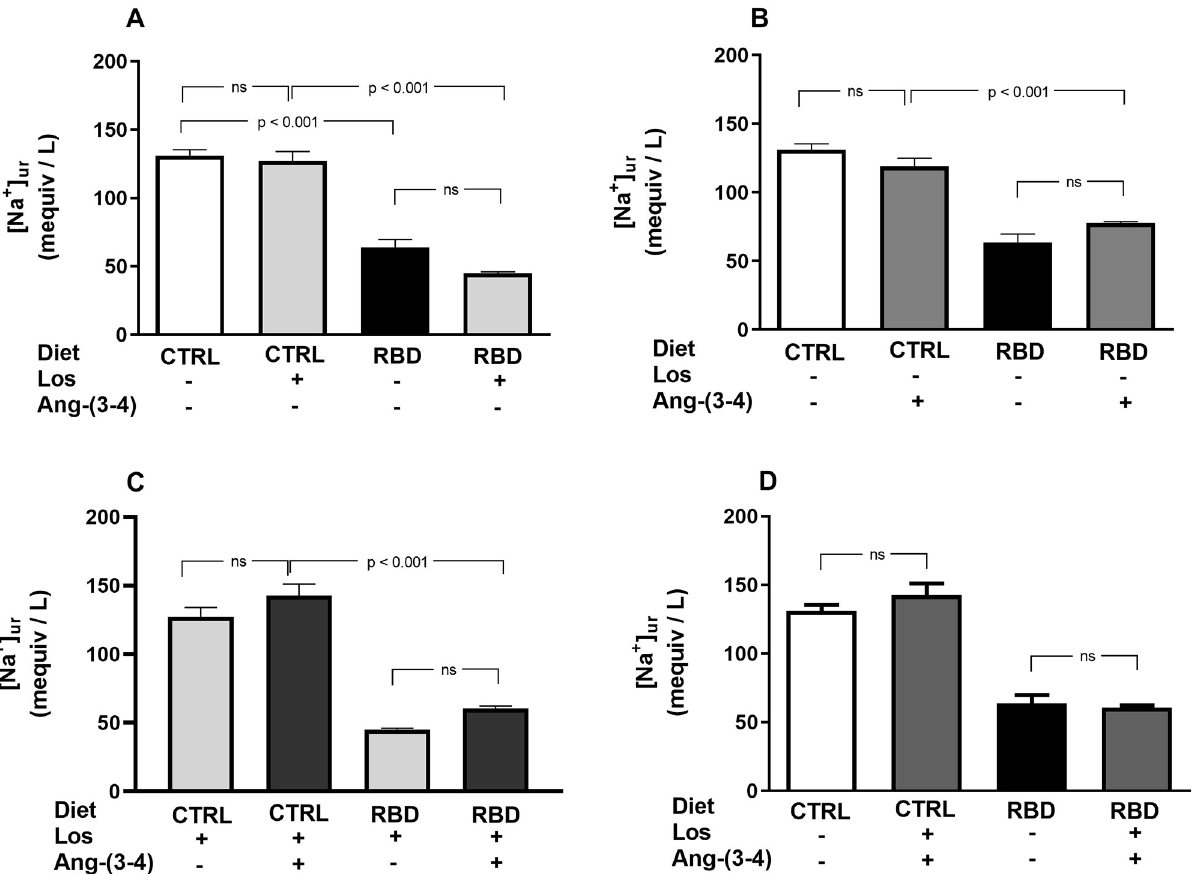
Fig 9. Urinary Na + concentration ([Na + ] ur ). Urine samples were collected between 90 and 91 days, except for Ang-(3–4)-treated rats, which were collected between 91 and 92 days. (A) Responses to Losartan. Comparison of [Na + ] ur in CTRL and RBD rats without chronic administration of Losartan, and effects of Losartan administration, as indicated on the abscissa . (B) Responses to Ang-(3–4). Effects of oral administration of a single dose of Ang-(3–4) on the [Na + ] ur of CTRL and RBD rats, as indicated on the abscissa . (C) Responses to Ang-(3–4) in rats previously treated with Losartan. Effects of oral administration of a single dose of Ang-(3–4) on the [Na + ] ur of CTRL and RBD rats previously treated with Losartan, as indicated on the abscissa . (D) Effects of combined Losartan+Ang-(3–4) administration. Comparison of [Na + ] ur between untreated CTRL and RBD rats vs . CTRL and RBD rats that were chronically given Losartan and a single dose of Ang-(3–4), as indicated on the abscissa . Bars are mean ± SEM; n = 5 (CTRL), n = 7 (RBD), n = 5 (CTRL+Los), n = 6 (RBD+Los), n = 5 (CTRL+Ang-(3–4)), n = 8 (RBD+Ang-(3–4)), n = 5 (CTRL+Los+Ang-(3–4)), n = 6 (RBD+Los +Ang-(3–4)). Differences between means were analyzed using one-way ANOVA followed by Bonferroni’s test for selected pairs. P values are indicated within t he